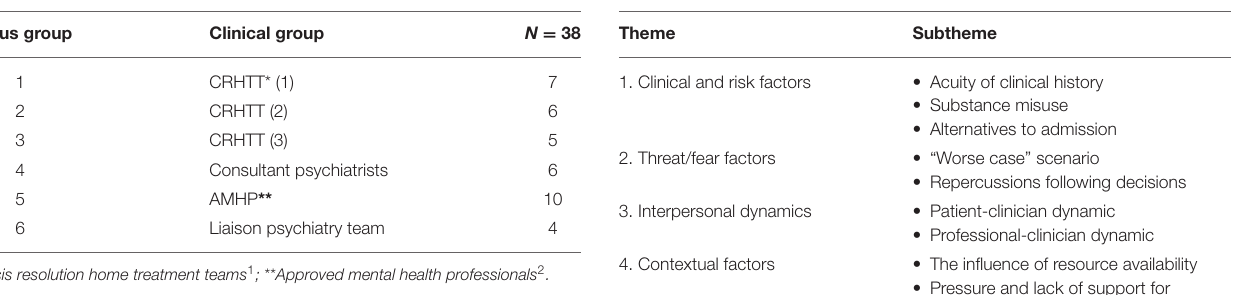
TABLE 2 | Overview of themes and